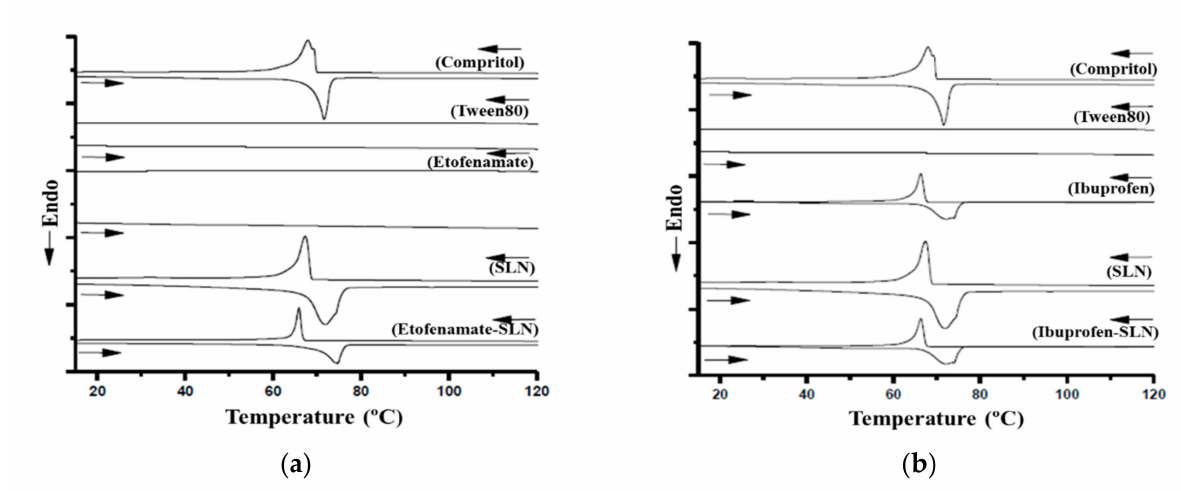
Figure 4. Differential scanning calorimetry (DSC) thermograms of etofenamate-loaded SLNs and individual components ( a ) and of ibuprofen-loaded SLNs and individual components ( b ). Compritol: Compritol ® 888